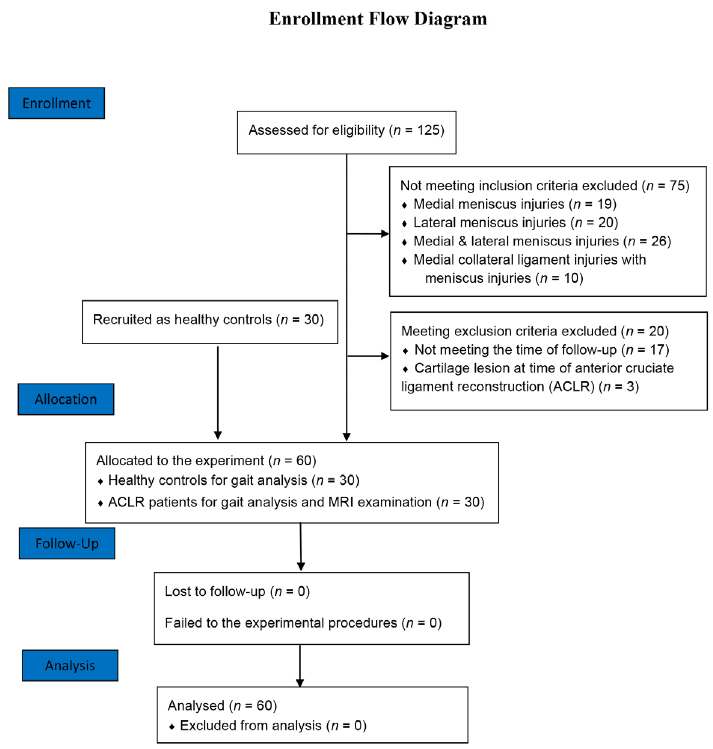
Figure 1. The flow diagram of the recruitment of the